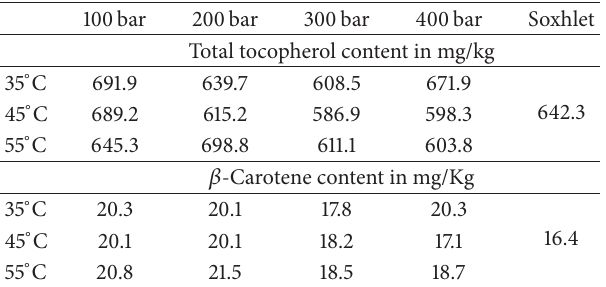
Table 5: Total tocopherol and 𝛽 -carotene contents for the oil